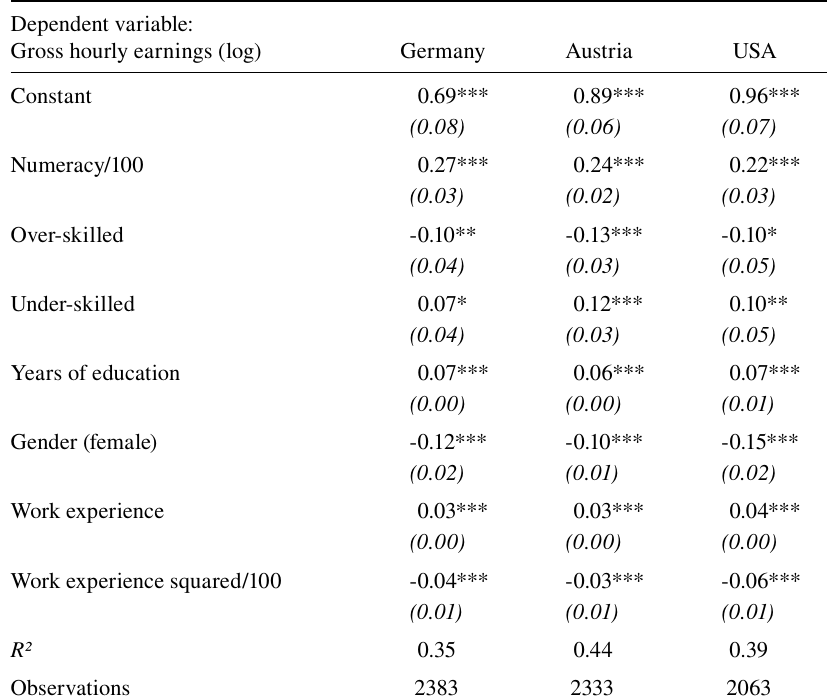
Mincer regressions with skill-mismatch according to Allen et al. (2013) and